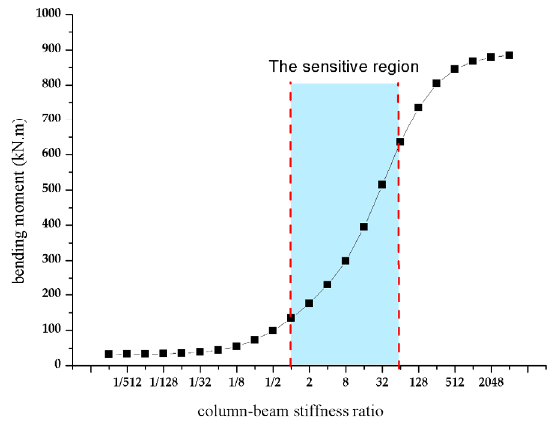
Figure 19. Relation curve of the column bottom bending moment with column–beam stiffness ratio.